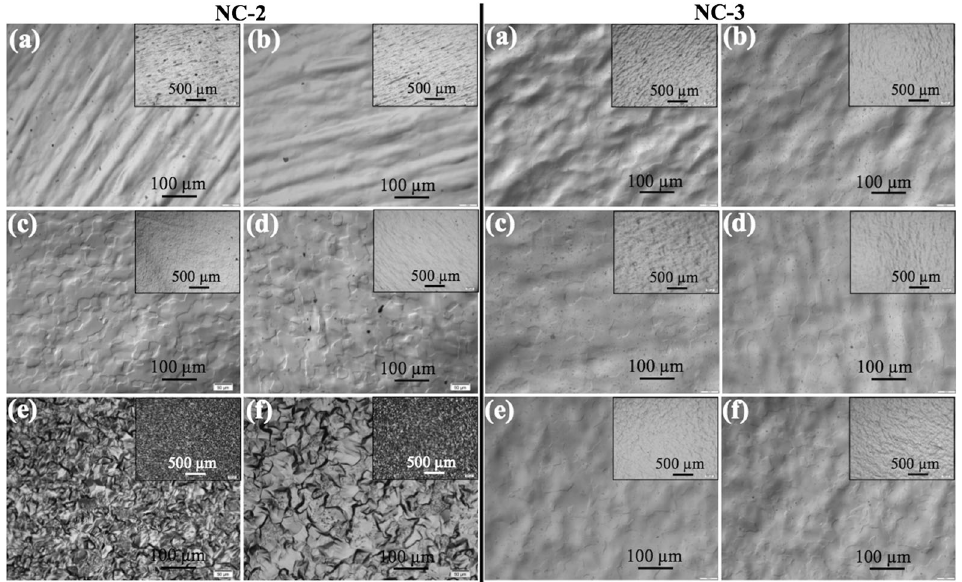
FIG. 19. Optical microscope images of the coupon surfaces after VEP with NC-2 (left) and NC-3 (right). Coupons located at (a) top beam pipe, (b) bottom beam pipe, (c) top iris, (d) bottom iris, (e) and (f) equator. Insets show zoomed-out images of